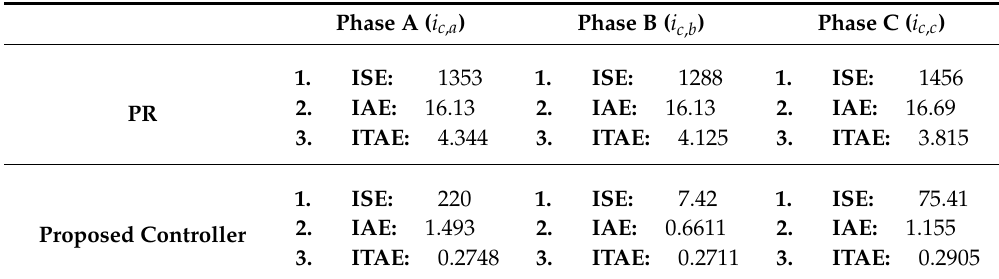
Table 2. Performance indices of circulating current